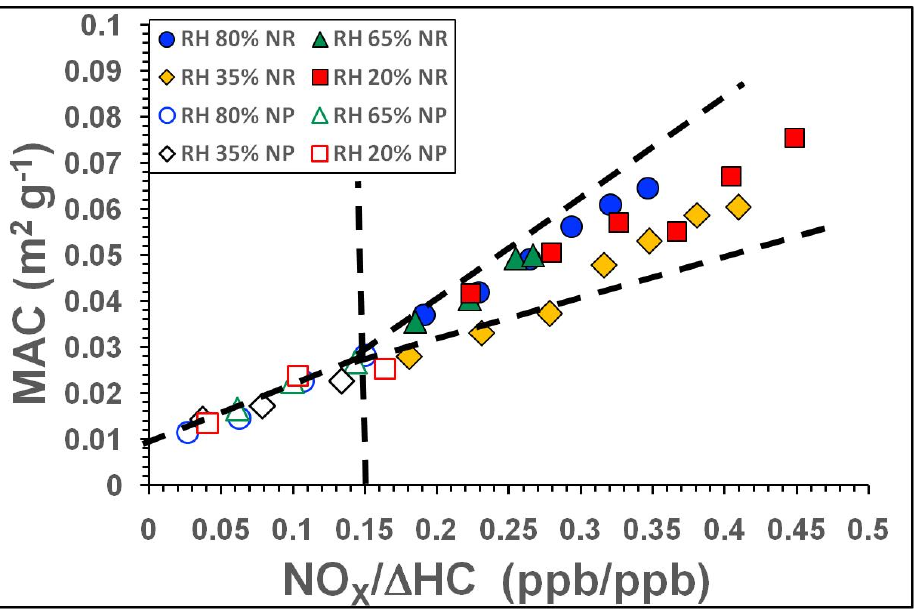
Figure 4. MAC (mass absorption cross-section) as a function of the [NO x ]/[ ∆ HC] ratio at 80%, 65%, 35% and 20% RH. Empty and filled symbols show results for NP and NR SOA, respectively. The dashed lines are included to guide the eye.